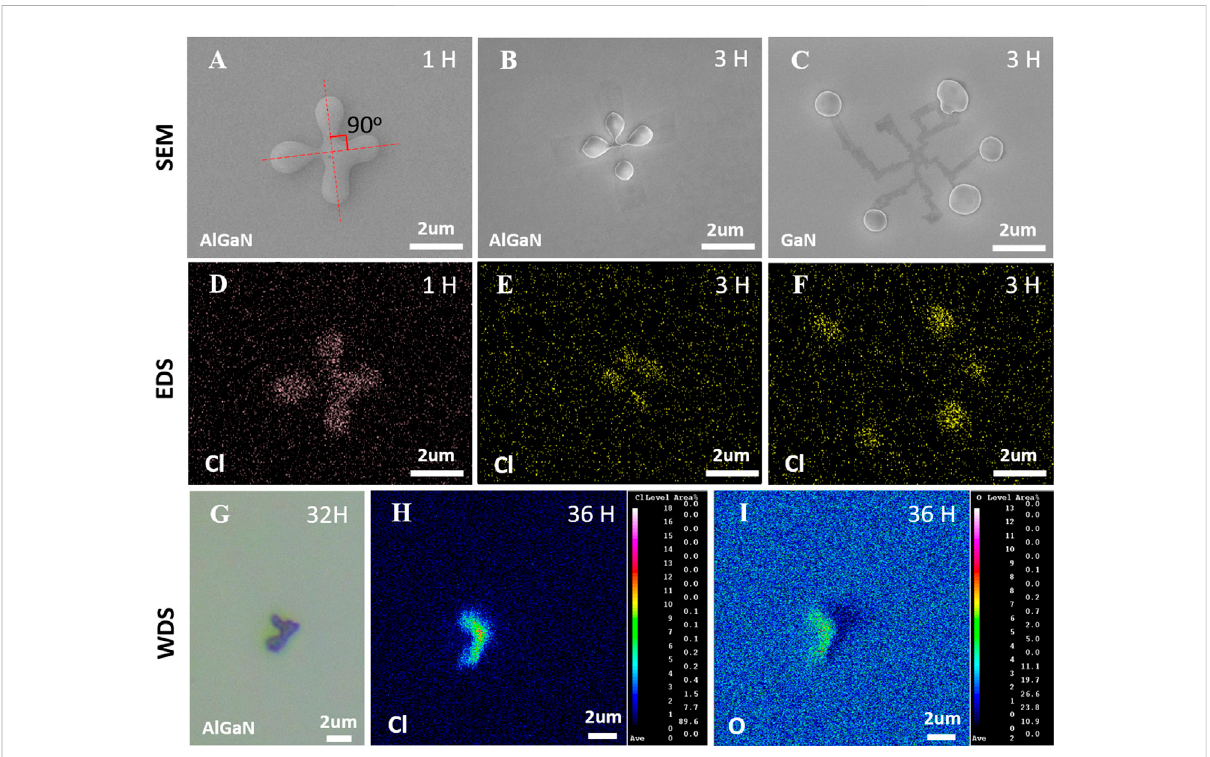
FIGURE 4 SEM images of surface debris when the etching was stopped on the Al 0.4 Ga 0.6 N layer (A) and (B) and on the GaN layer (C) after the samples exposing in air for a few hours. Fig.4 (D – F) are EDS mappings of Cl corresponding to the SEM image area in (A – C) . Fig.4 (G) is the OM picture of surface debris when the etching was stopped on the Al 0.4 Ga 0.6 N layer after the samples exposing in air for 32 h. Fig.4 (H – I) are WDS mappings of Cl and O corresponding to the OM image in (G)